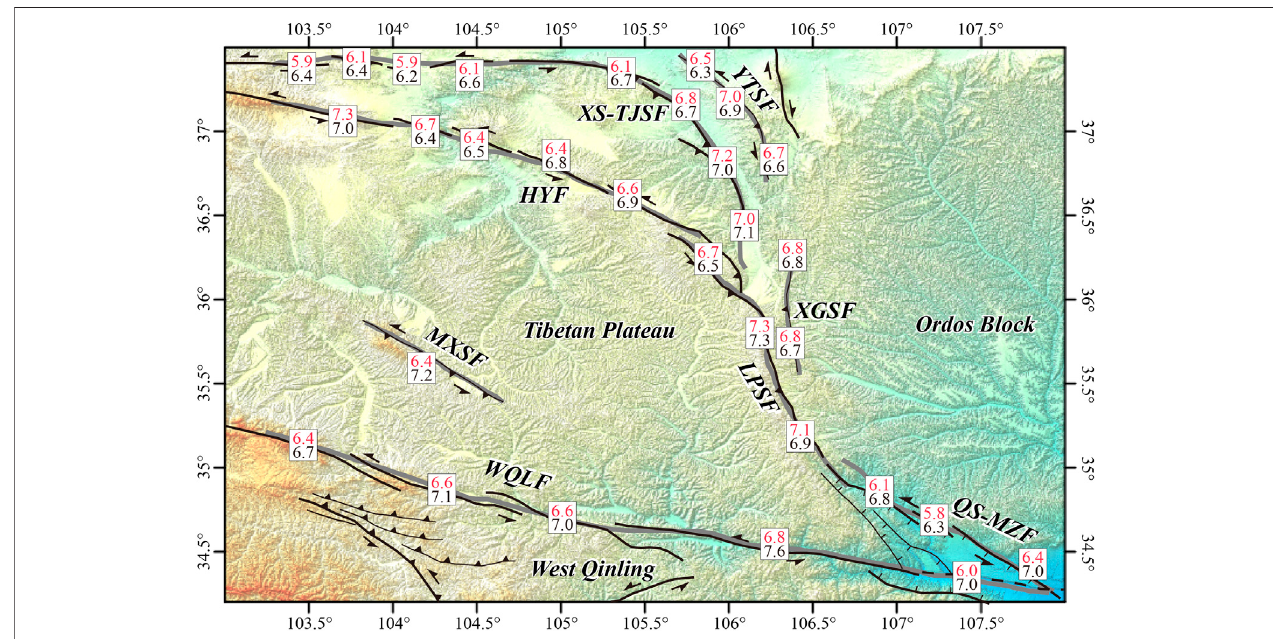
FIGURE14| EstimatedmomentmagnitudeofmajoractivefaultsinthenortheasternmarginoftheTibetanPlateau.Rednumbersrepresentresultsfromtherupture area-moment magnitude empirical formula, and black numbers represent results from the rupture length-moment magnitude empirical formula.